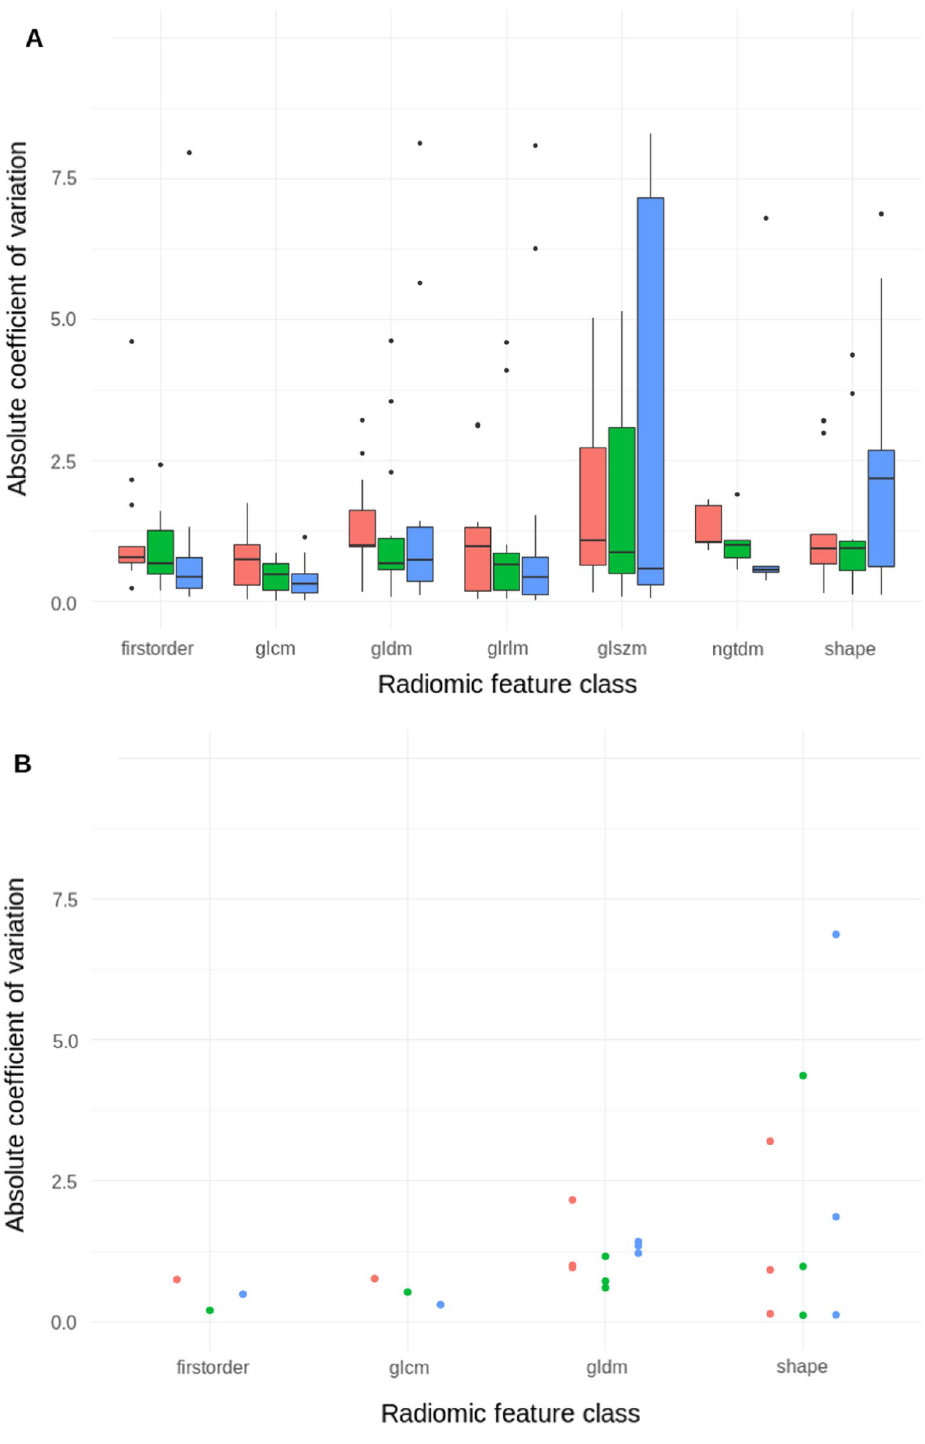
Figure 4. Absolute coefficient of variation considering ( A ) all 107 radiomic features; ( B ) eight robust and uncorrelated radiomic features (Sensitivity analysis) for cohort L. Radiomics features are subdivided by patient (one color per patient) and the commonly used radiomic features’ classes. All radiomics features exhibited high level of variation for each of the three patients, with shape and glszm features being the most affected. Theses levels of variation were similar with the robust and uncorrelated radiomic features’ set. glcm: Gray Level Co-occurrence Matrix ; gldm: Gray Level Dependence Matrix; glrlm: Gray Level Run Length Matrix; glszm: Gray Level Size Zone; ngtdm: Neighbouring Gray Tone Difference